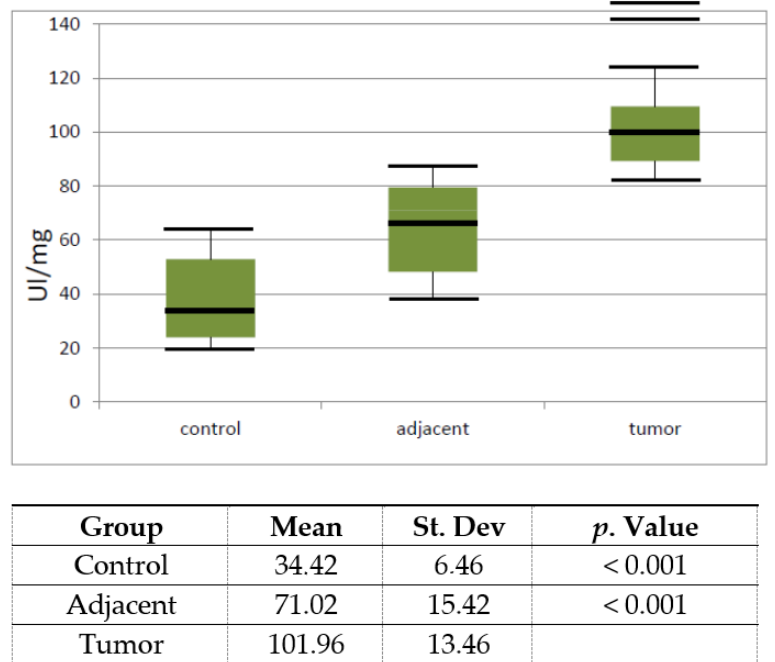
Figure 1. Vertical boxplot for Xanthine oxidase activity in control healthy tissue, tissue adjacent to tumor and tumor prostate tissue. The median is identified by a line inside the box, the boundaries of the box are interquartile range (IQR). Bars = entire range. Values more than 75th percentile are labelled as extreme and denoted as the horizontal lines beyond the bars.